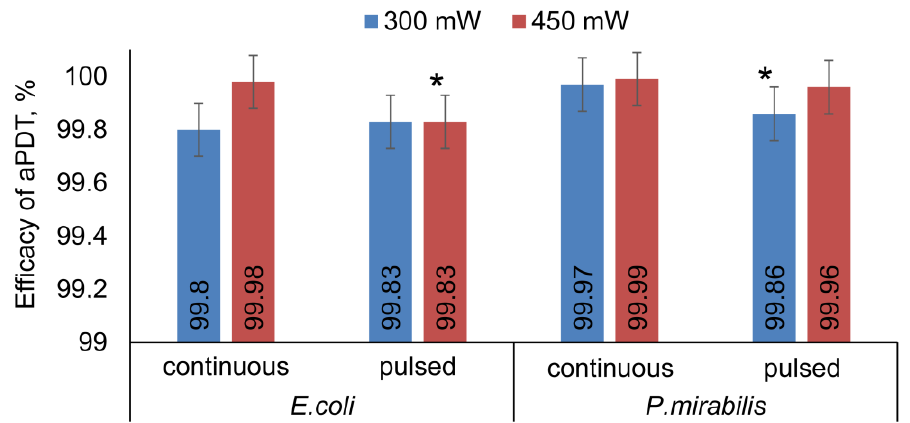
Figure 5. The influence of pulsed laser irradiation on the efficacy of aPDT of Gram-negative bacteria. Bacteria were incubated with Fotoditazin and Triton X-100 for 15 min at room temperature in the dark, and illuminated by pulsed laser (100 ms pulse width and 5 Hz repetition rate) at different output powers. Statistically significant differences compared to the corresponding species irradiated by continuous wave laser (*) are marked.